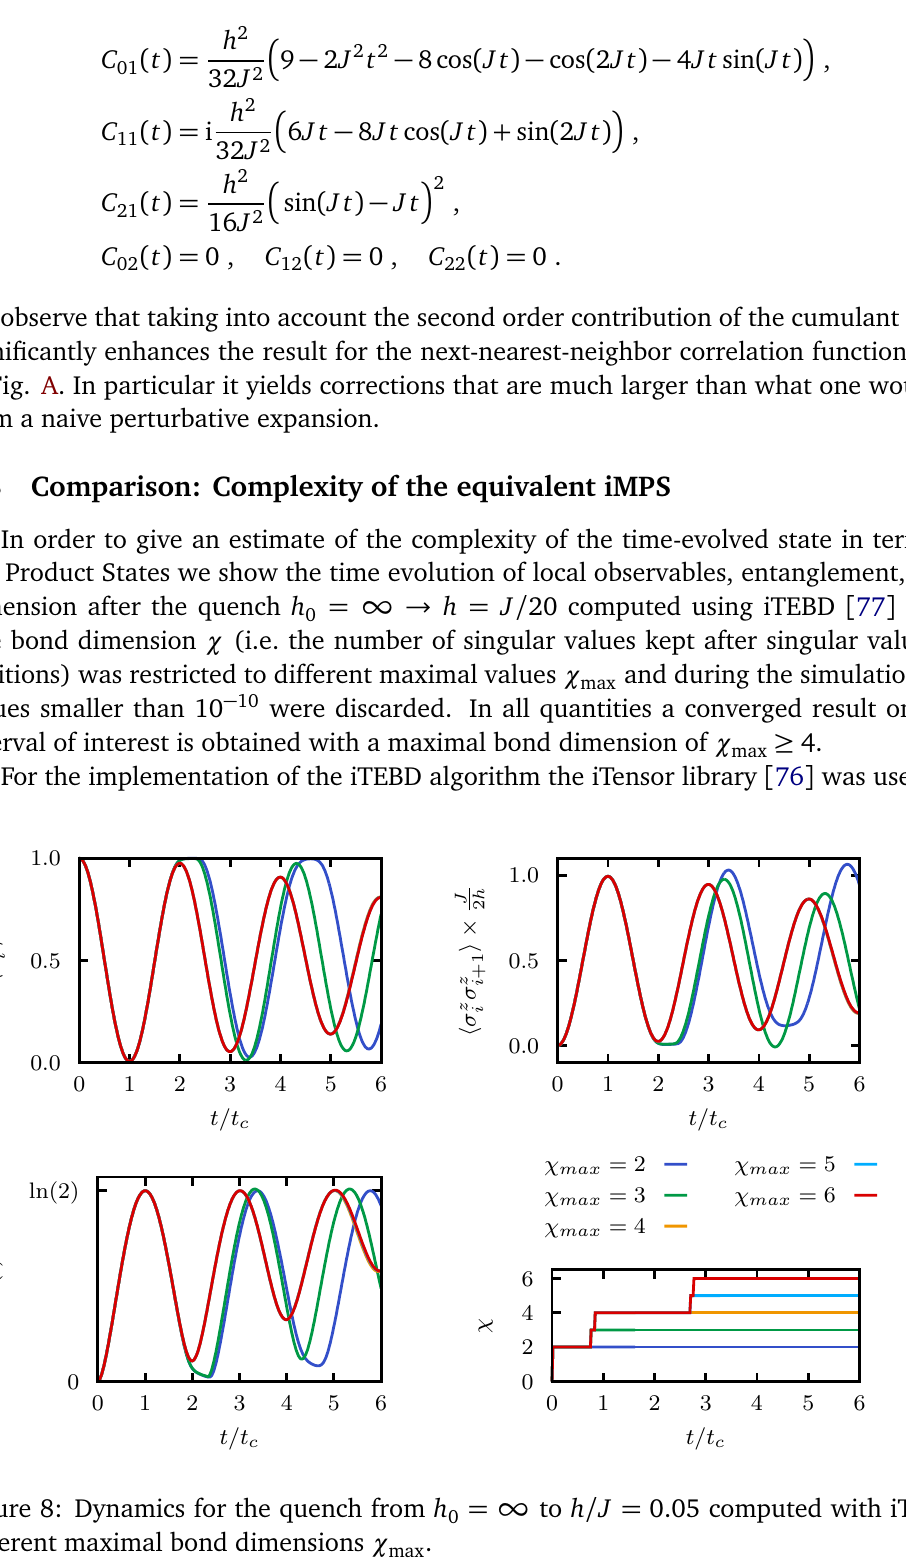
Figure 8: Dynamics for the quench from h different maximal bond dimensions χ